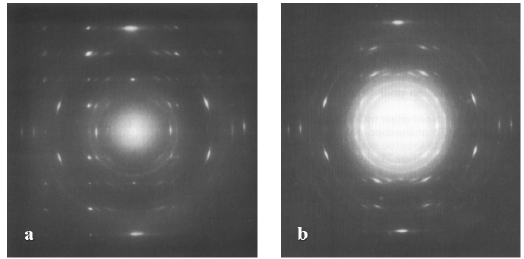
Figure 18. Electron diffraction patterns of iPBu crystallized on 2-Quinoxalinol substrate before ( a ) and after ( b ) removing the substrate crystals. The sharp and arced spots correspond to the diffraction by the substrate and polymer, respectively. The appearance of strong meridional spot on the fourth layer line is an indication of a 4/1 helical conformation, i.e., the formation of form III iPBu crystals. Reproduced with permission from Ref. [117], copyright 1994 Butterworth-Heinemann Ltd.